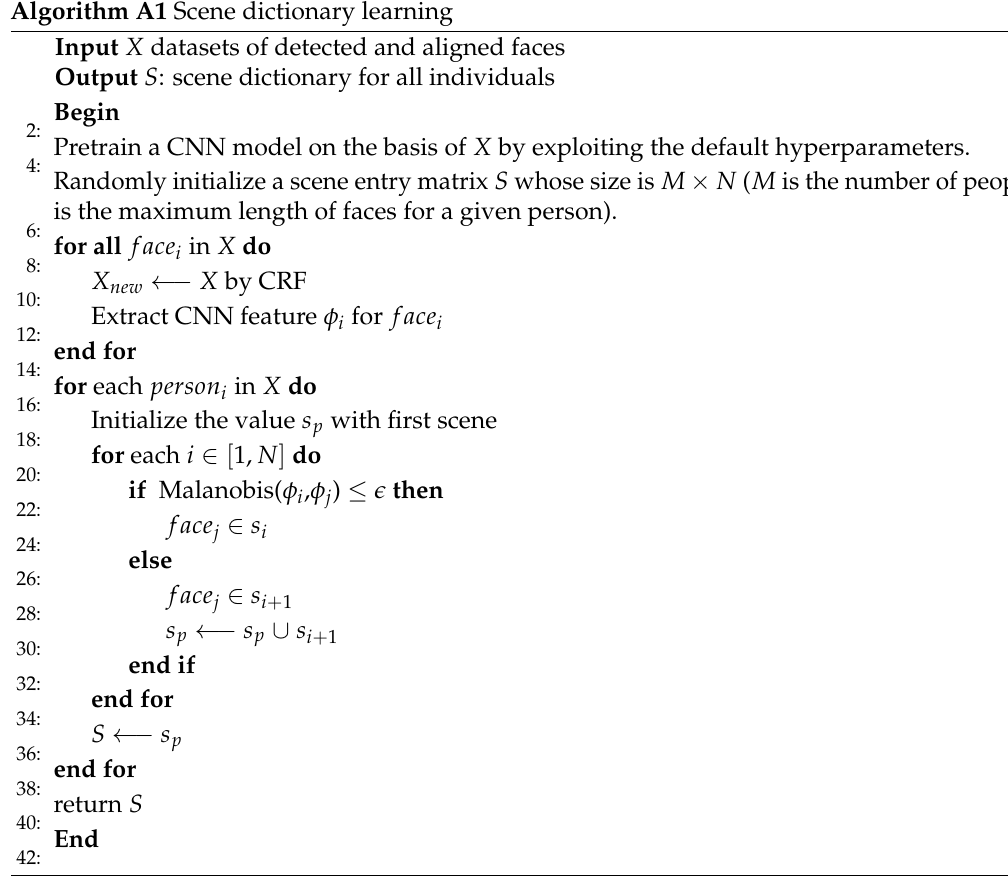
Algorithm A1 Scene dictionary